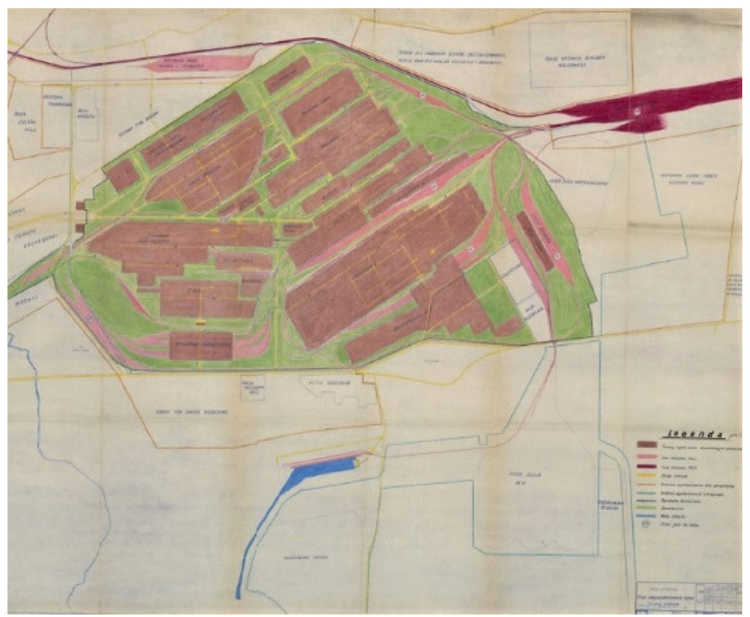
Figure 7. The functional and spatial concept of the metallurgical combine Huta im. Lenin—As of 1949.